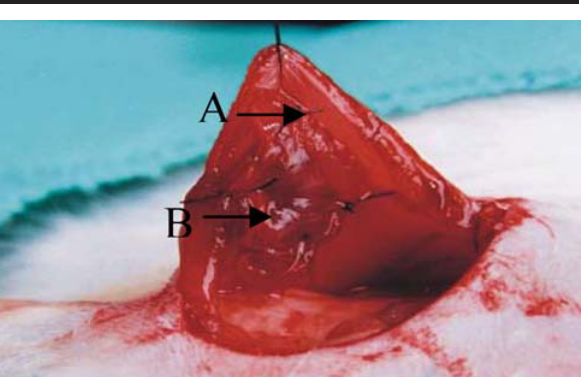
FIGURA 3 - Ilustração de inguinotomia à direita para implante do espécime. Aparede do canal inguinal. Bespécime implantando.